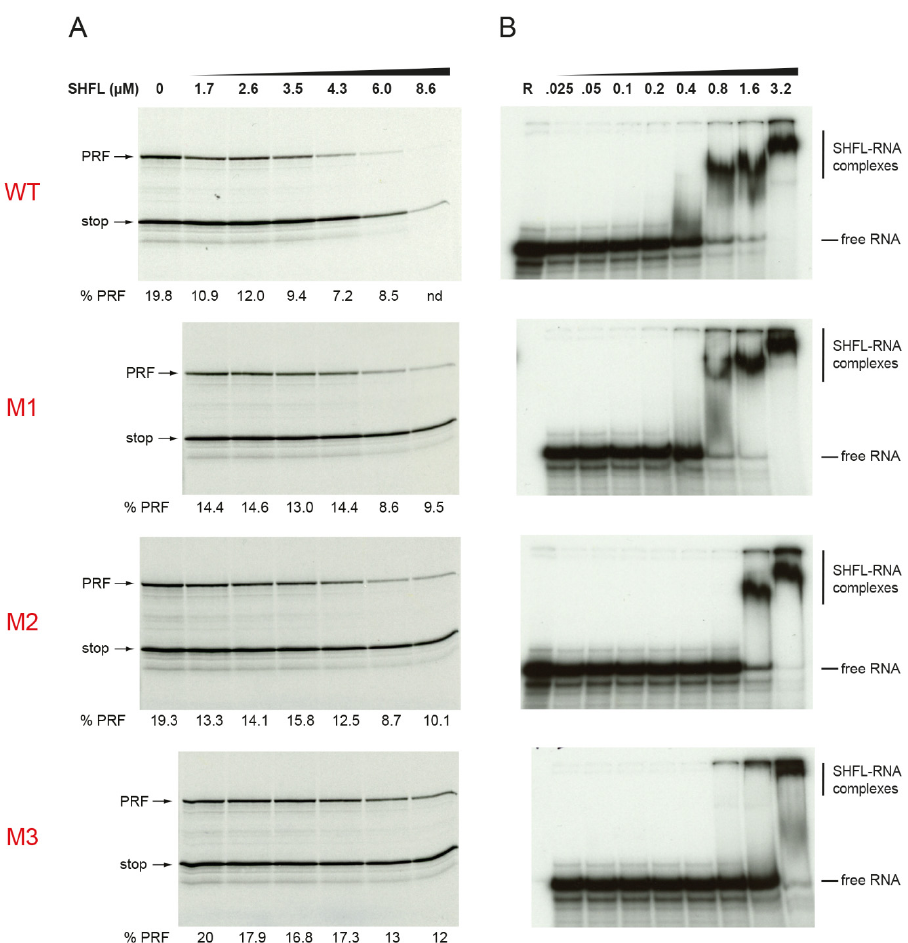
Figure 6. Activity of mutant derivatives of SHFL . ( A ) An mRNA derived from pDluc/SARS-CoV-2 was translated in RRL in the presence of the indicated concentrations of His-tagged SHFL (WT) or mutant derivative (M1, M2, M3). The addition of SHFL dilution buffer (DB) only is indicated. The products were resolved and analyzed as detailed in the legend to Figure 3. ( B ) EMSA analysis of binding of SHFL (WT) or mutant derivative (M1, M2, M3) to a 32 P-labeled in vitro transcript containing the IBVmax PK. The EMSA was carried out and processed as detailed in the legend of Figure 4. The original gels from which the panels of this Figure are derived as shown in Supplementary Figure 1.